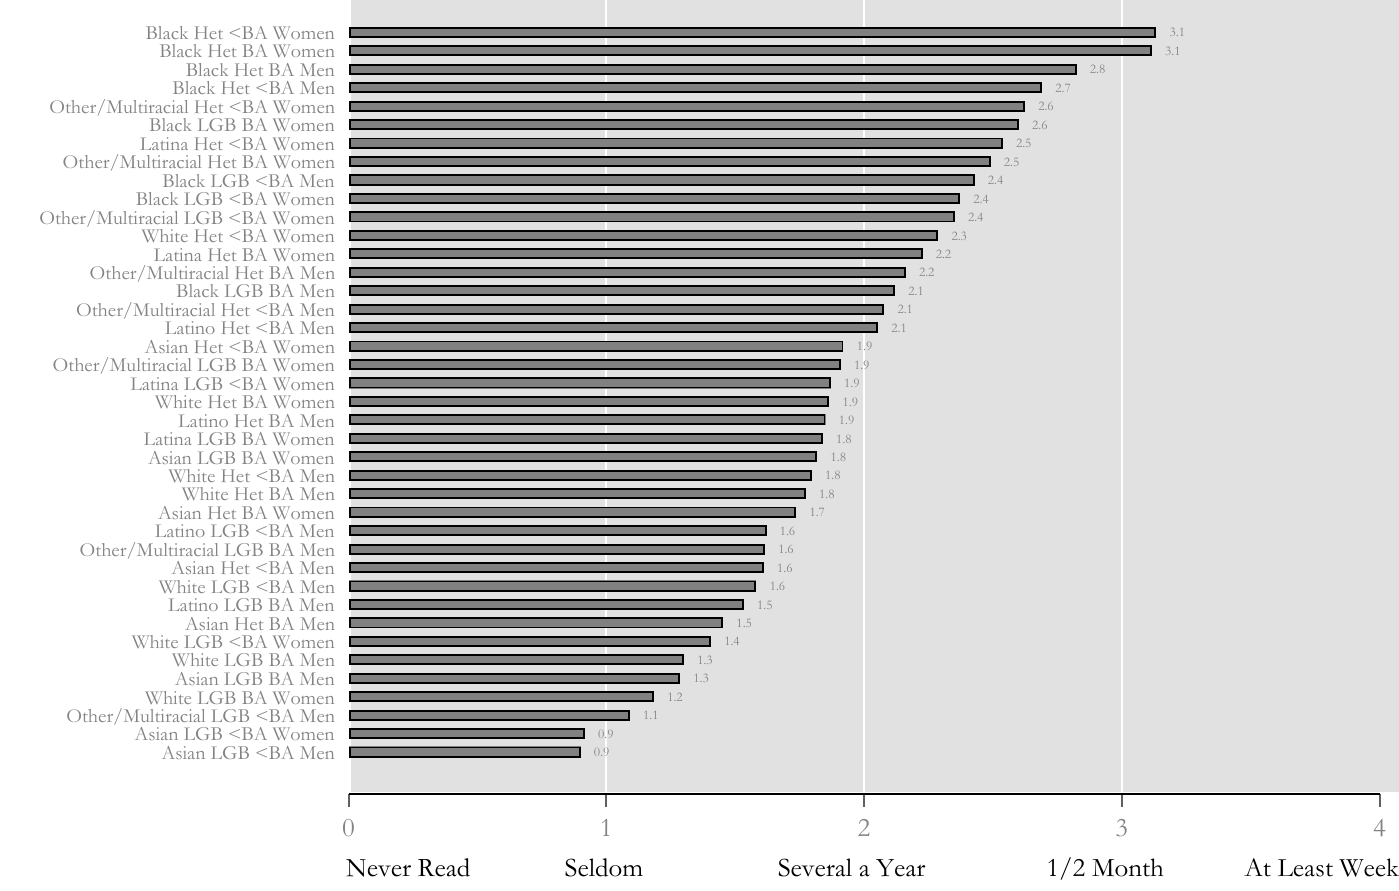
Figure A2. Scripture reading frequency, RLS (N = 33,258).